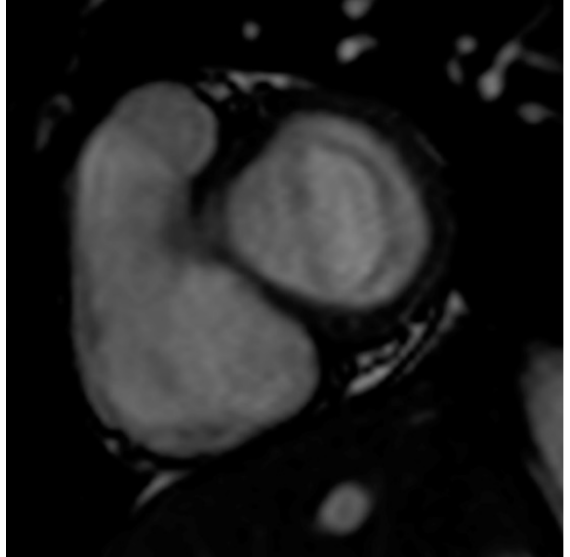
Figure 1. Determination of the most basal layer of the left ventricle at the transition to the left atrium. The myocardial ring is at least 50% complete.